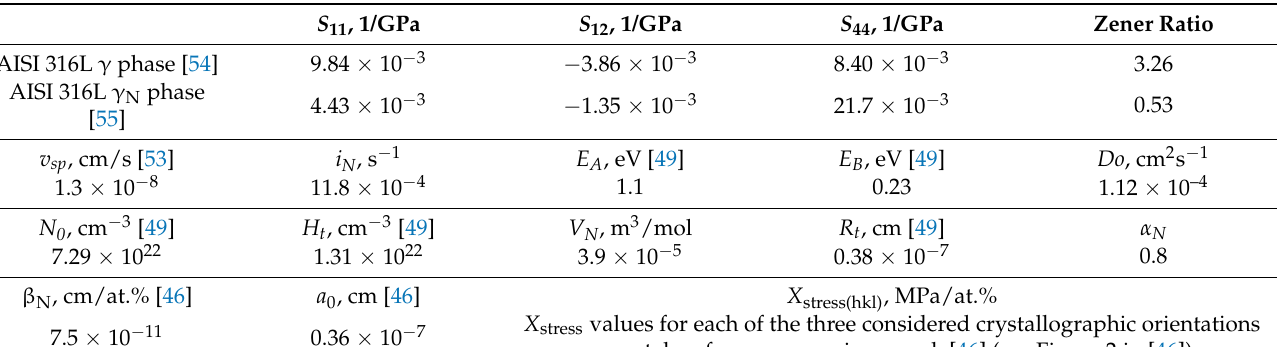
Table 1. Simulation